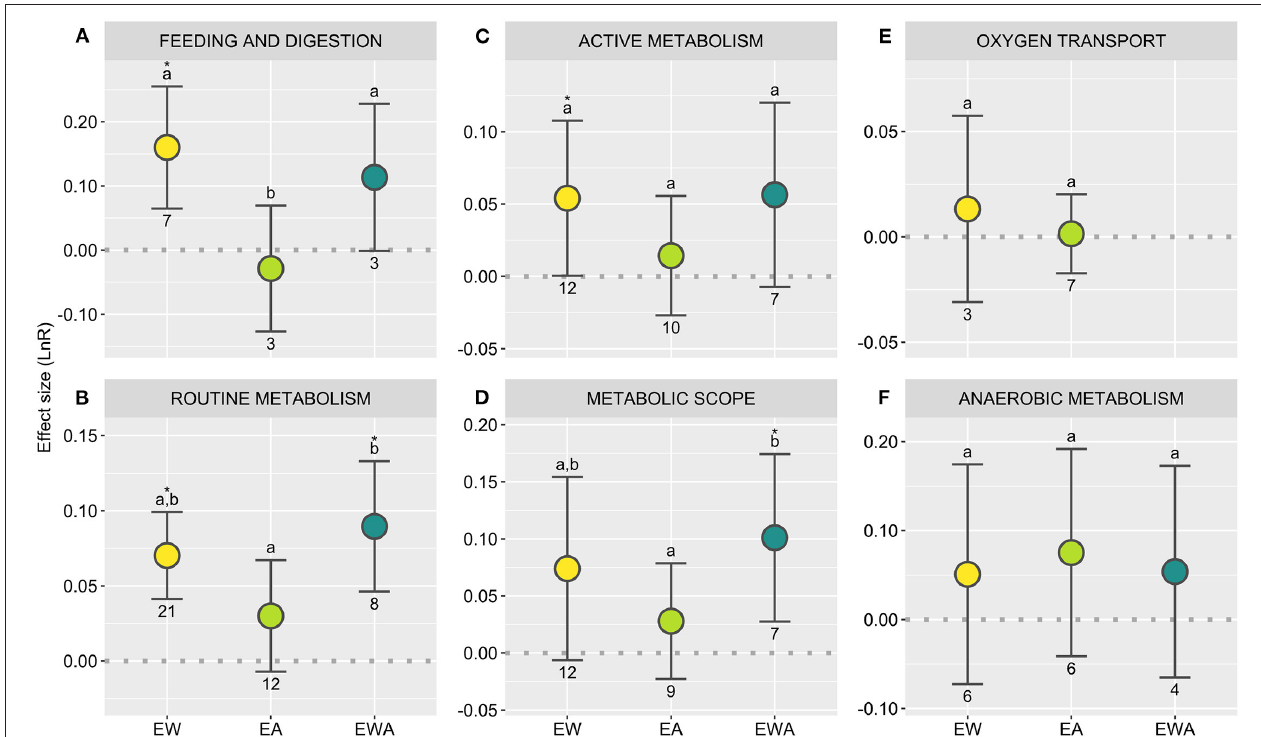
FIGURE 5 | Directional effects size (LnR) of experimental warming (EW), acidification (EA), and their combination (EWA) over elasmobranchs, considering specific biological responses [ (A) Feeding and digestion; (B–D) Aerobic metabolism; (E) Oxygen transport; (F) Anaerobic metabolism]. The dashed line (R = 0) represents the threshold used to test the null hypothesis, with overlapping confidence intervals (CI) indicating the lack of significant treatment effect. R values above 0 indicate a stimulation and below indicates an inhibition of the response; asterisks indicate a significant effect. Different letters showcase differences between treatments; numbers indicate sample sizes (number of control-treatment contrasts). Statistical results are detailed in Supplementary Table 3